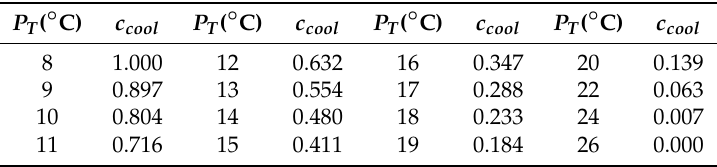
Table 3. Unitary costs for cooling